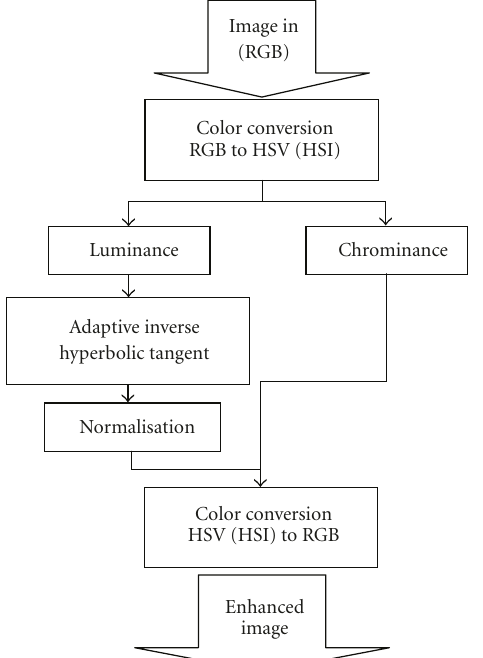
Figure 7: A flowchart of the AIHT algorithm.